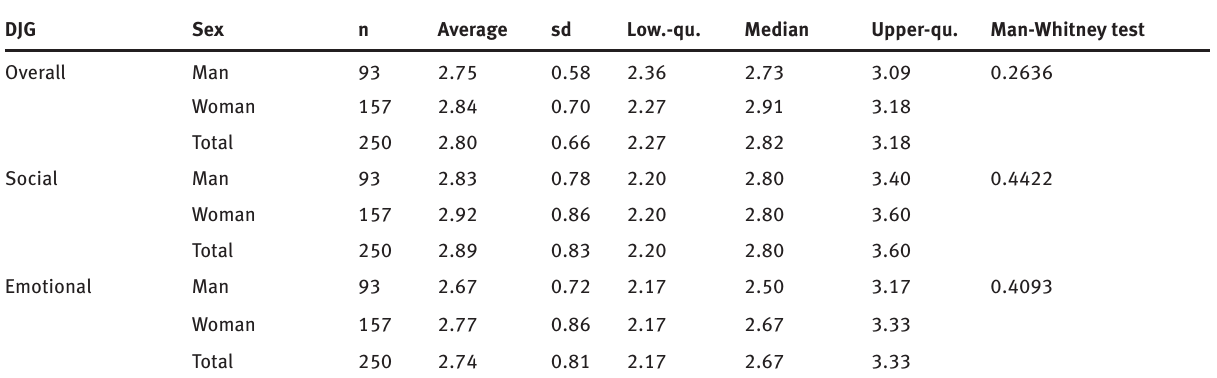
Table 5: Feeling of social and emotional loneliness as per DJG (the values are question averages)